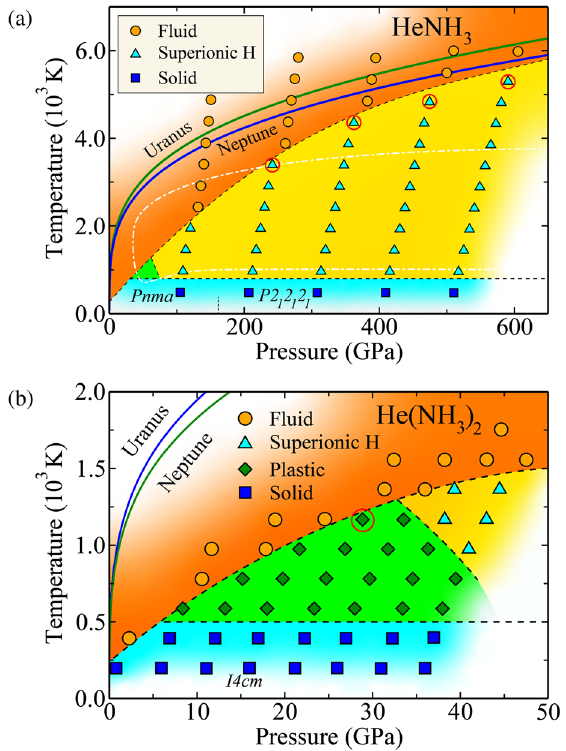
FIG. 3. Proposed phase diagram of HeNH 3 (a) and He ð NH 3 Þ 2 (b) at high pressures obtained from structure searches and AIMD simulations. The simulations are marked with four different symbols: blue square, dark green diamond, cyan triangle, and orange circle represent the solid, plastic, superionic, and fluid states, respectively. Black dashed lines are fitted to the phase transition boundaries. The calculated isentrope for Uranus (Neptune) is shown as a thick dark green (dark blue) line. The white dash-dotted line covers the superionic phase in pure ammonia, taken from Redmer et al. [20]. Red solid circles mark some trajectories in which the superionic hydrogen or plastic phases coexist with diffusive helium, which has much smaller diffusion coefficients than superionic hydrogen near the phase